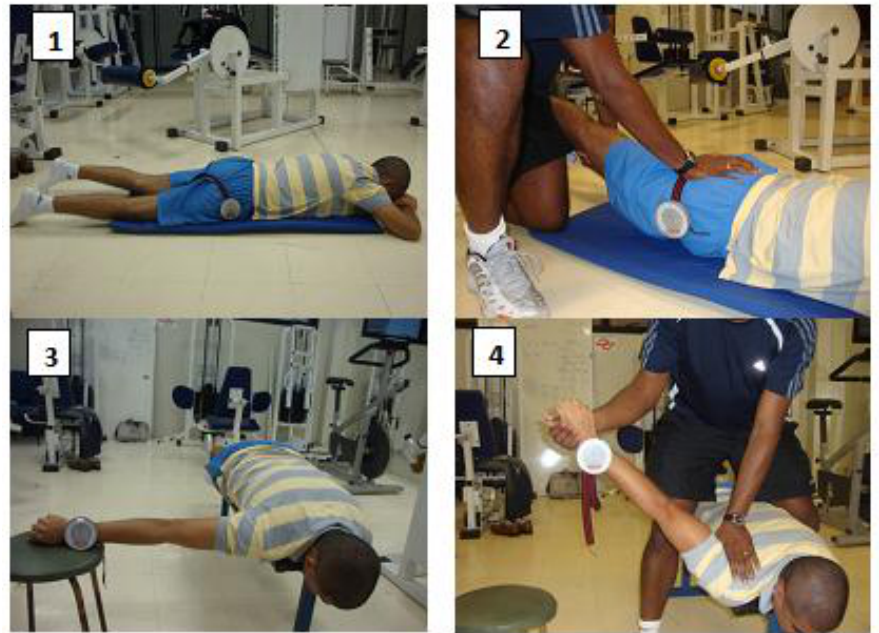
Figura 1. Posição inicial e final dos testes de flexibilidade da extensão de quadril (fotos 1 e 2) e da abdução do ombro (fotos 3 e